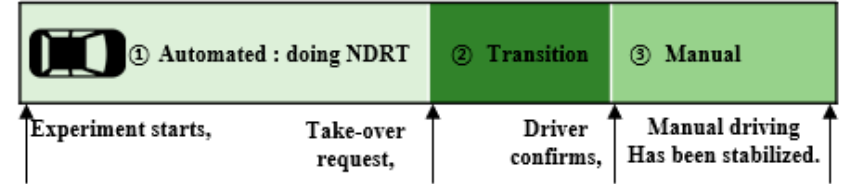
Figure 1. Concept of control authority transition from automated driving system (ADS) to driver [10].